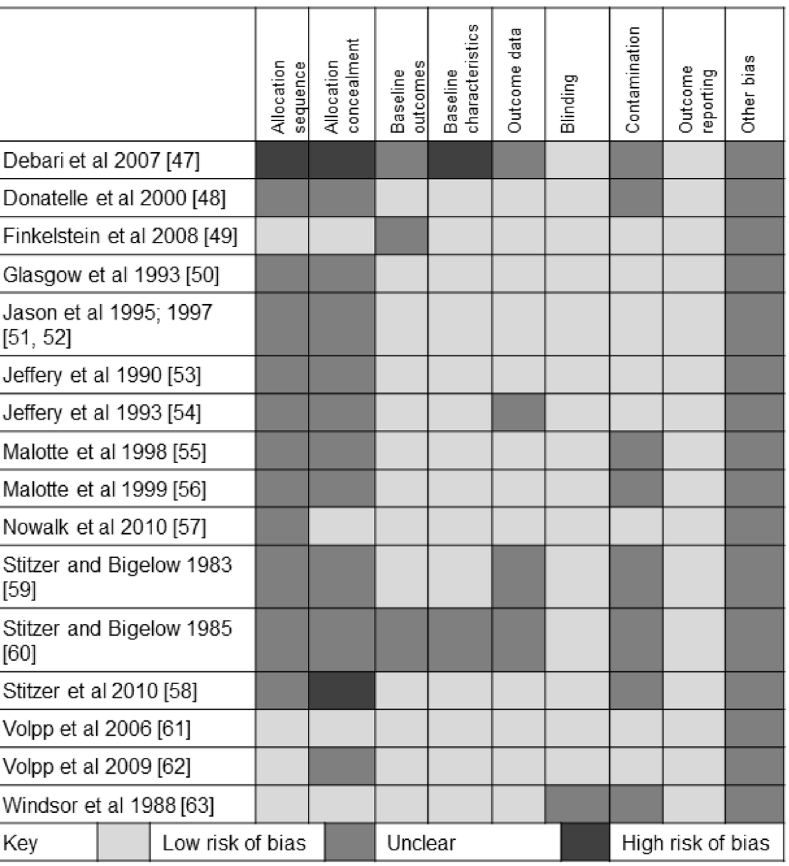
Figure 2. Risk of bias in included studies. doi:10.1371/journal.pone.0090347.g002 Nine relevant comparisons from four studies were included in a meta-analysis. The average RR (95%CI) was 1.92 (1.46 to 2.53) (Figure 11) with evidence of a high level of heterogeneity